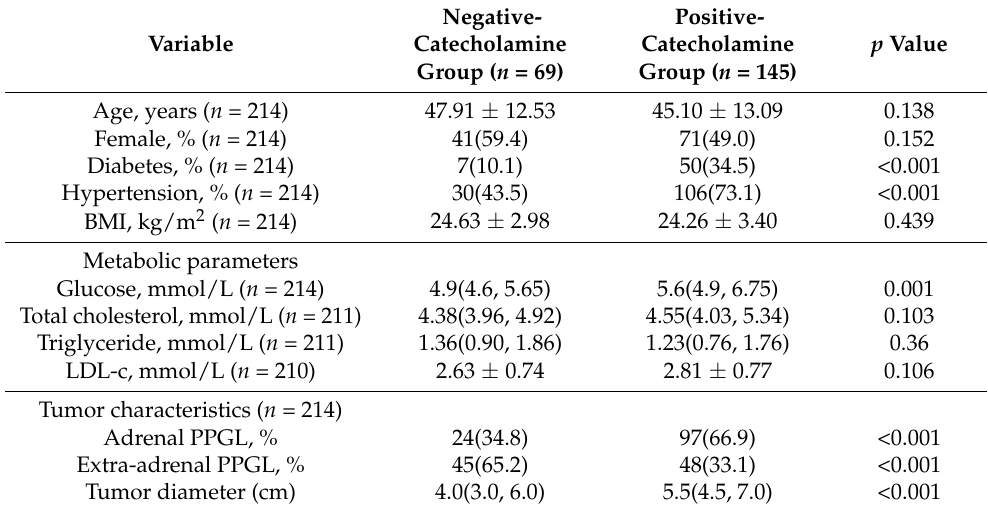
Table 2. Clinical characteristics of the patients in the positive- and negative-catecholamine